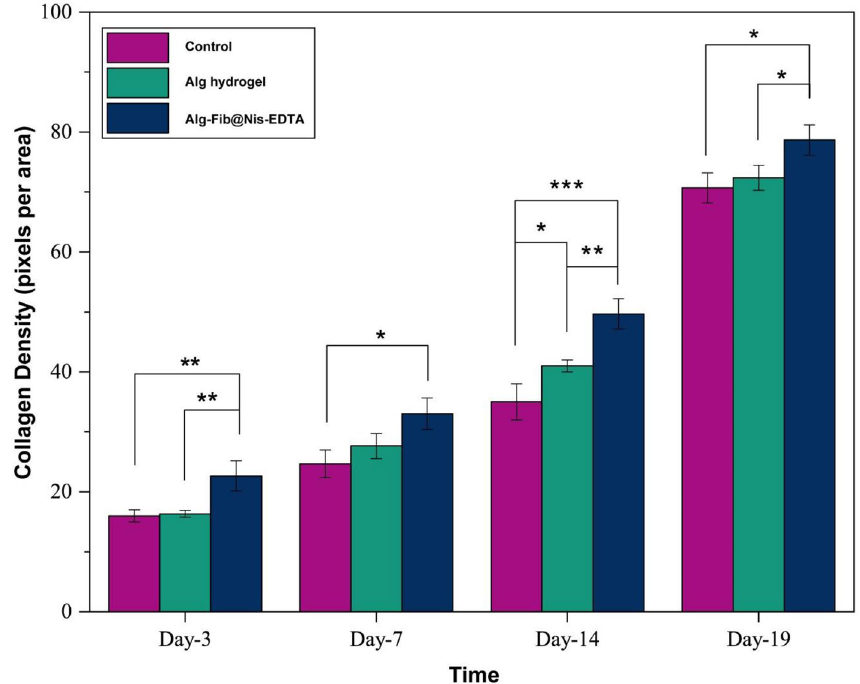
Figure 9. Representative graphical of collagen density at different time-points (3, 7, 14, and 19 d) confirming more wound healing in Alg-Fib@Nis-EDTA compared with other groups. These results were in consistent with the results obtained from wound closure. Values represent the mean ± SD, n = 3, p < 0 .05, ** p < 0 .01, and ** p < 0.001. SD: standard